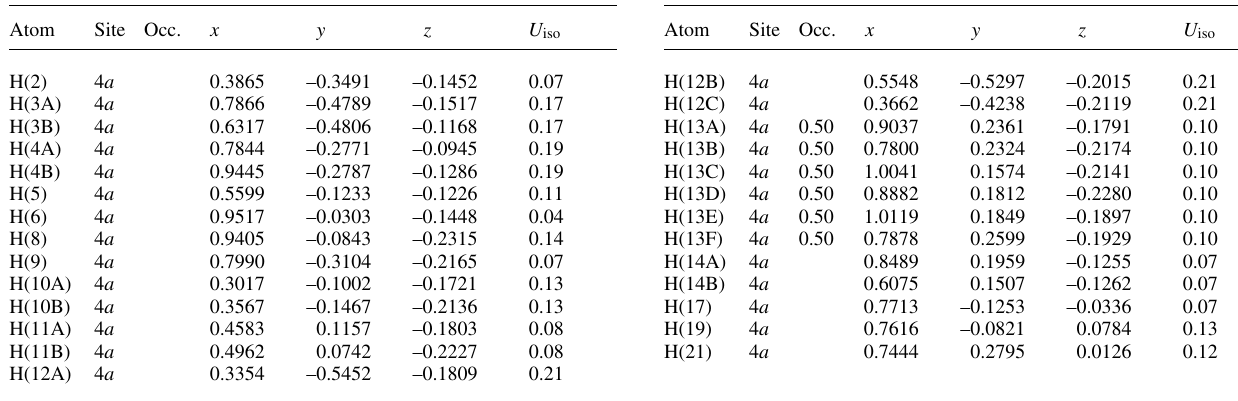
Table 2. Atomic coordinates and displacement parameters (in Å 2 )